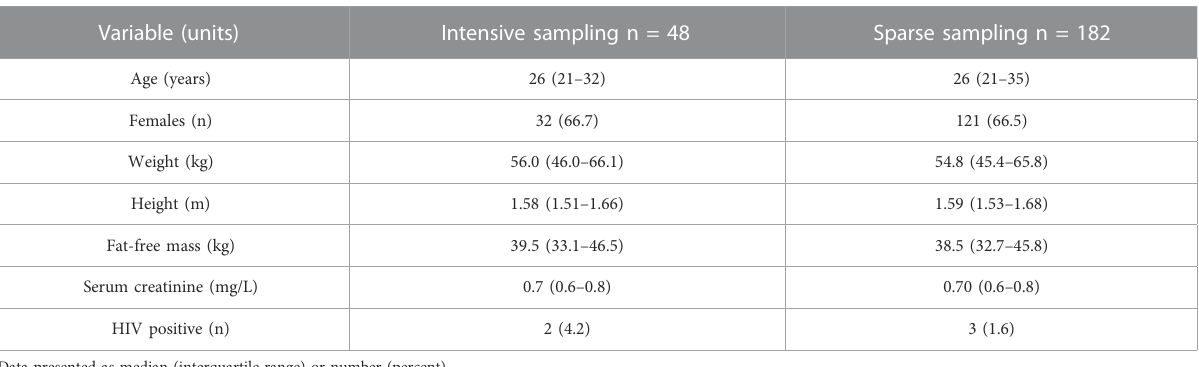
TABLE 1 Characteristics of the study